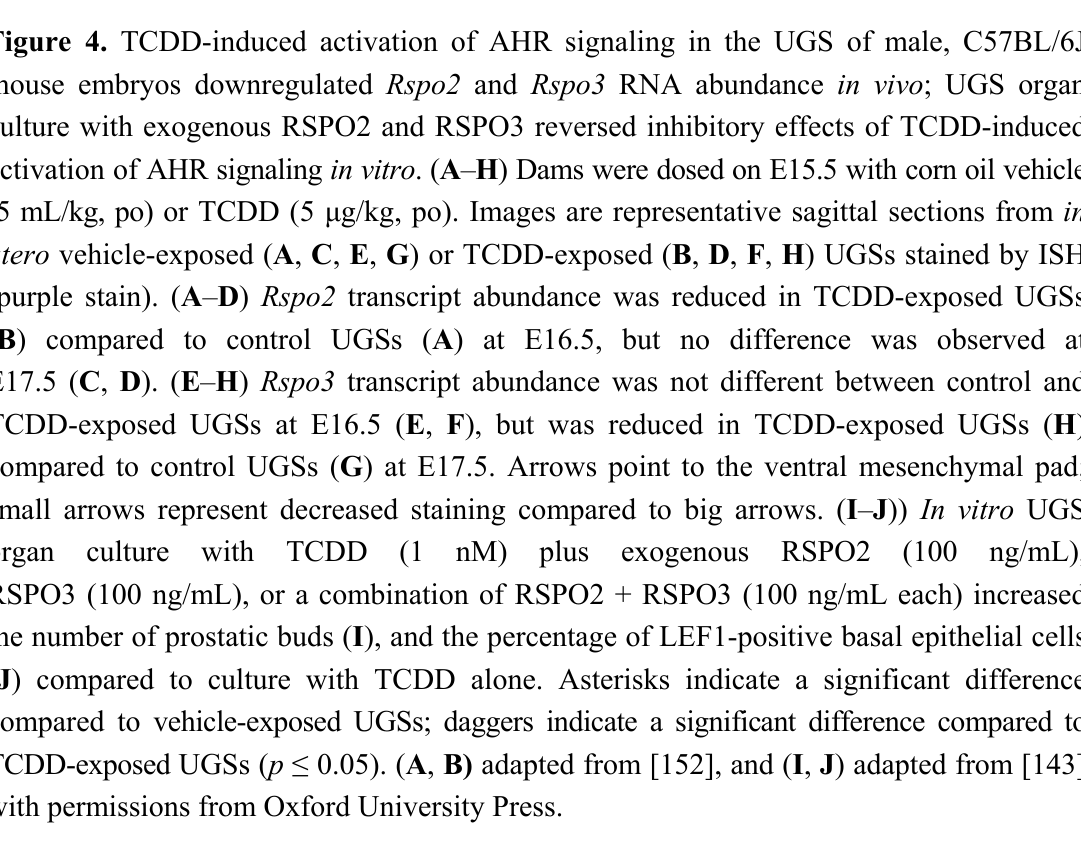
Figure 4. TCDD-induced activation of AHR signaling in the UGS of male, C57BL/6J mouse embryos downregulated Rspo2 and Rspo3 RNA abundance in vivo ; UGS organ culture with exogenous RSPO2 and RSPO3 reversed inhibitory effects of